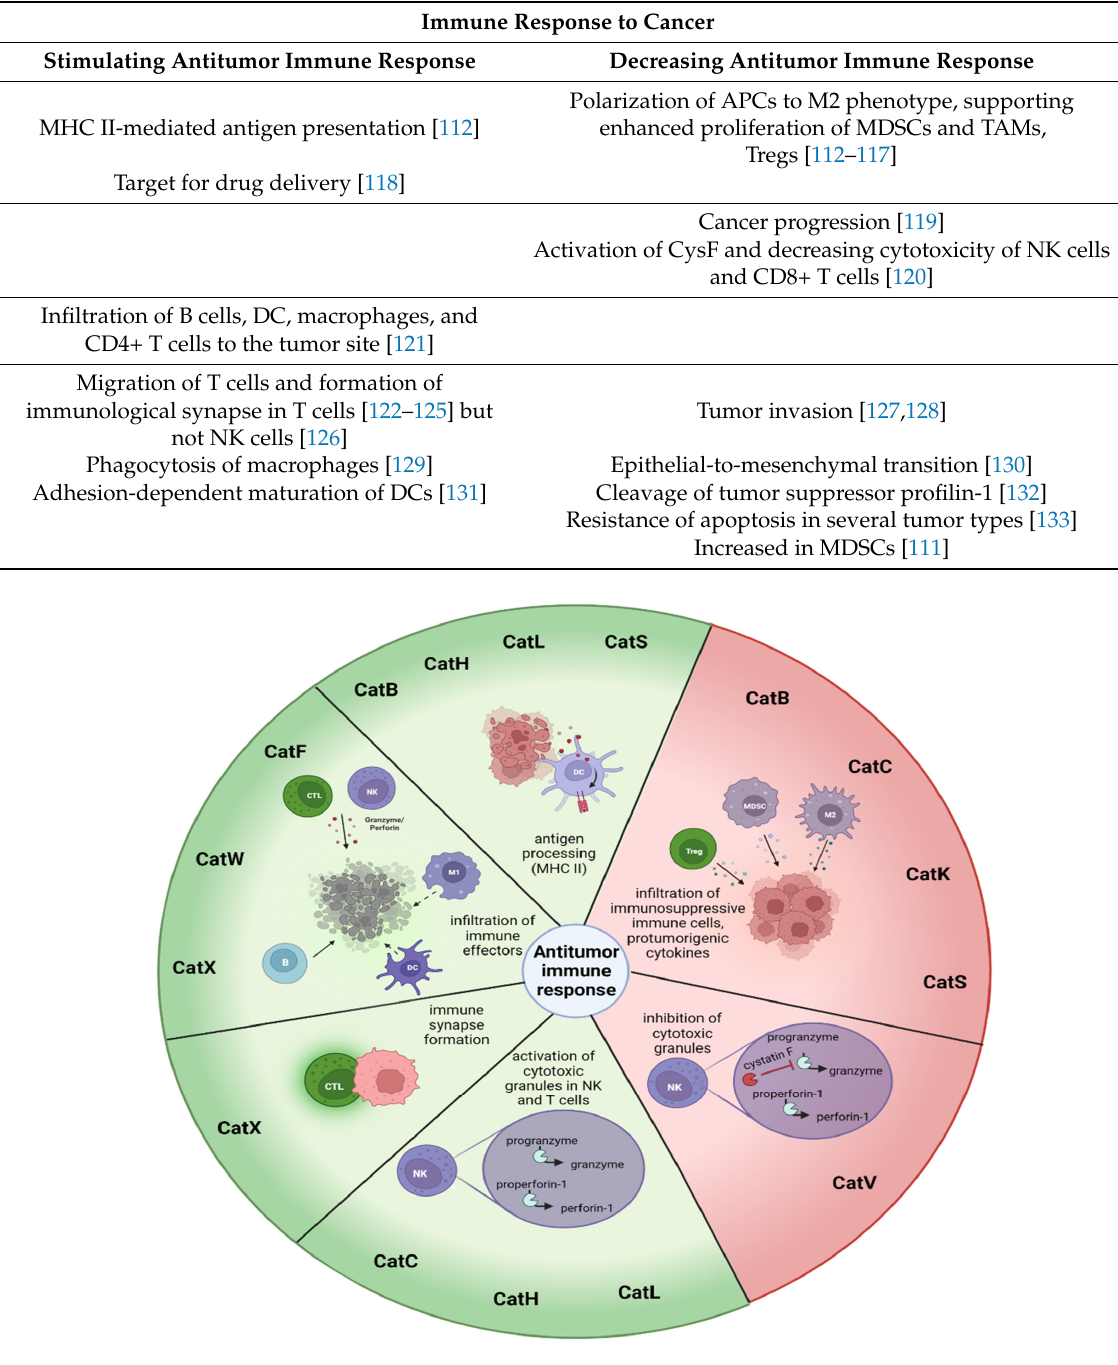
CTLs. Red T-bar arrow indicates inhibitory pathway, while black arrows indicate activation pathways (curved) or movements of the cells (straight). Created with